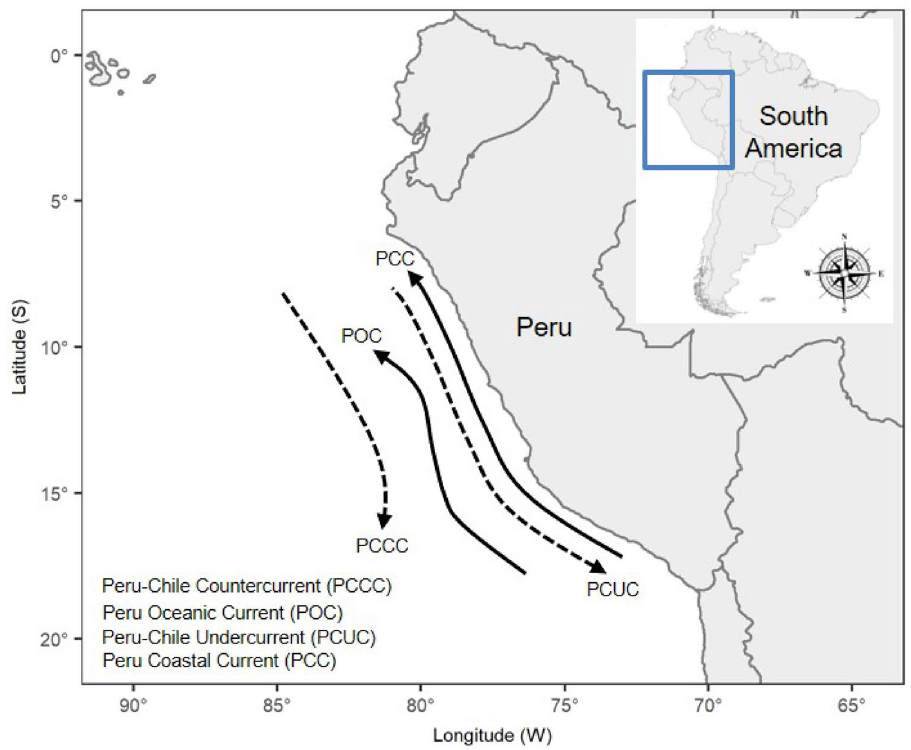
Figure 1. Peruvian portion of the Northern Humboldt Current System. Sub-surface (dashed line) and surface (solid line) currents are not to scale. The Peru–Chile Countercurrent flows southward and veers to the west at around 15°S. The Peru Oceanic Current flows equatorward at > 150 km offshore. The Peru–Chile Undercurrent flows poleward along the outer continental shelf and inner slope. The Peru Coastal Current flows equatorward and close to the coast 1–3